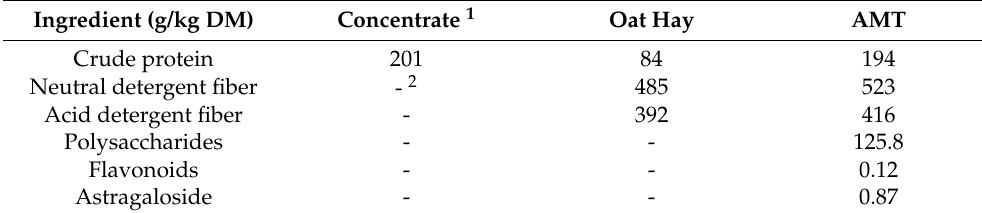
Table 1. Composition (DM basis) of the concentrate, oat hay and Astragalus membranaceus root (AMT). Ingredient (g/kg